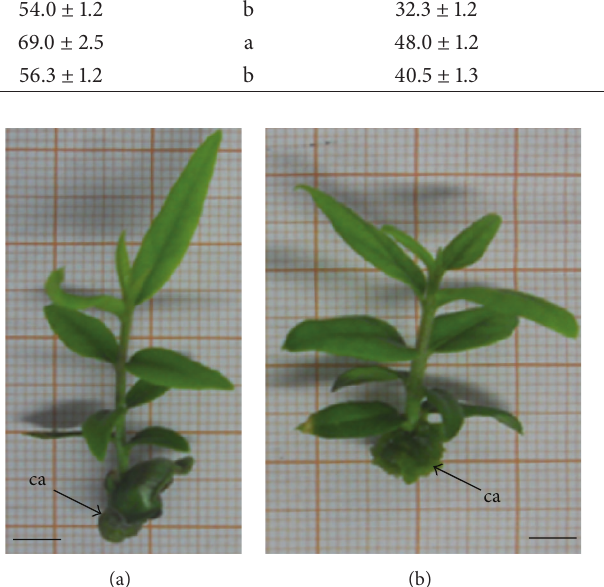
Figure 1: Vegetative growth of seedling-derived cuttings (Sc s ) of Olea europaea L. subsp. europaea var. sylvestris after 45 days on ORZ 5 : olive medium + 5 mg/L (23 𝜇 M) trans -zeatin (a) and (b) MSZ 5 : Murashige and Shoog medium 5mg/L (23 𝜇 M) trans -zeatin, respectively. ca: callus. (a), (b) = 0.8